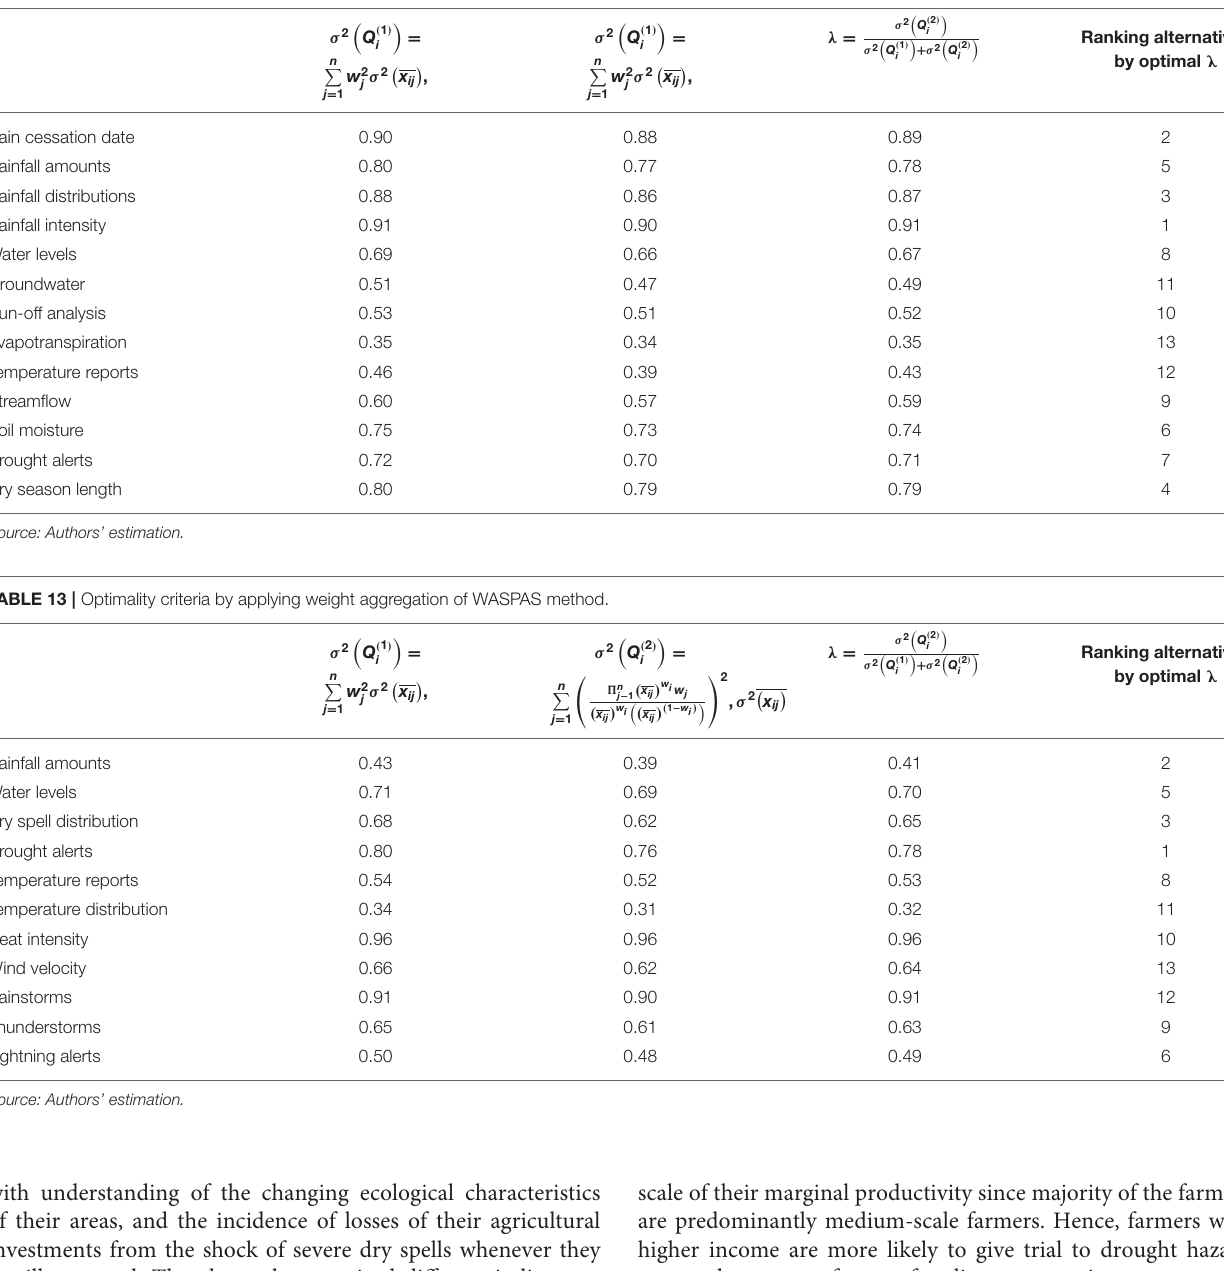
TABLE 12 | Optimality criteria by applying weight aggregation of WASPAS method.